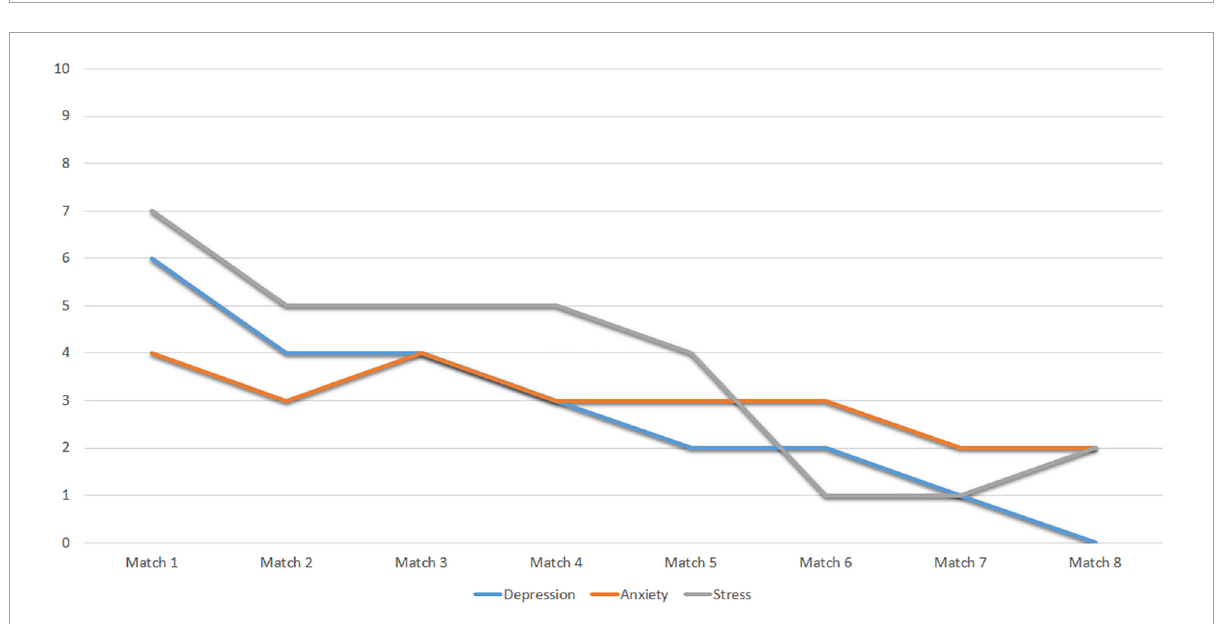
FIGURE7 POMS profile of subject 2 after training weeks.